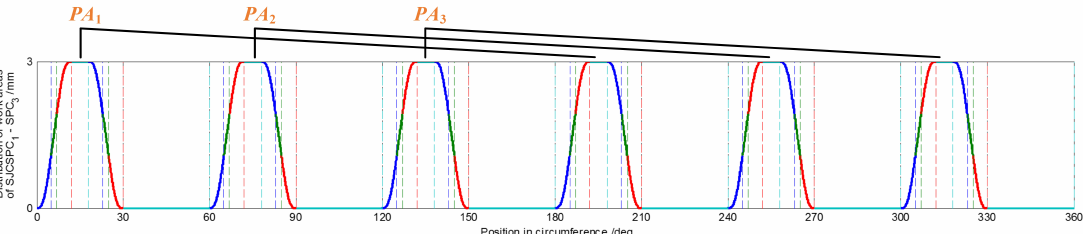
Figure 14. The phase among work areas PA 1 – PA 3 of SPC 1 – SPC 3 is driven synchronously by a switch motor. The phase among work areas PA 1 – PA 3 of SJC 1 – SJC 3 is the same as SPC 1 – SPC 3 .